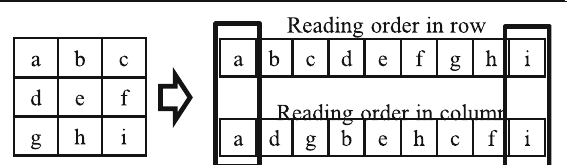
Fig. 4 Reading order example of the image. In this study, to maximize the steganographic capacity of a digital image, before image steganography, reading in order in rows and columns is performed,